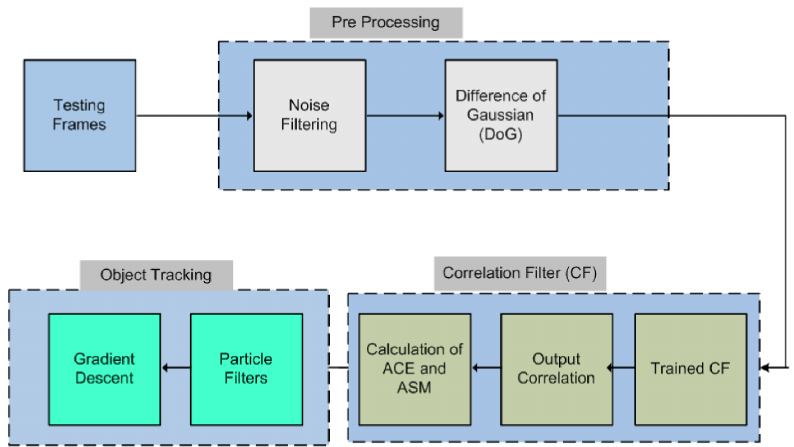
Figure 1. Proposed model of a